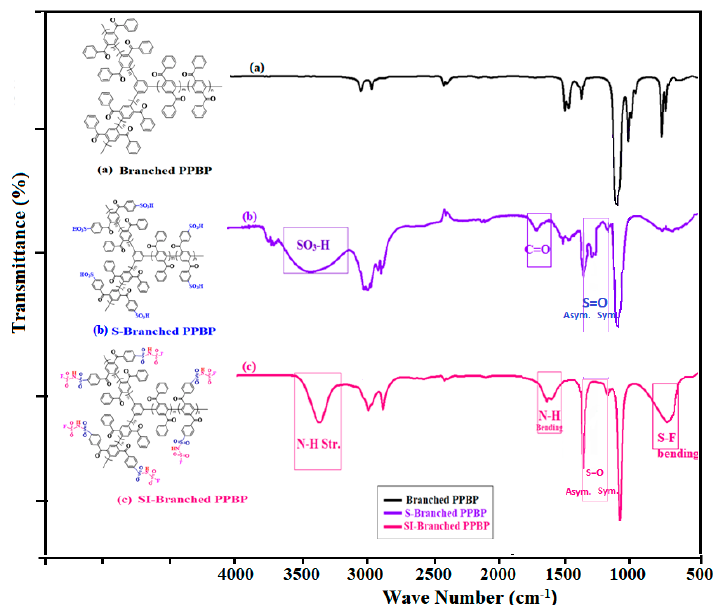
Figure 2. FT-IR for branched PPBP, S-branched PPBP and SI-branched PPBP polymers.